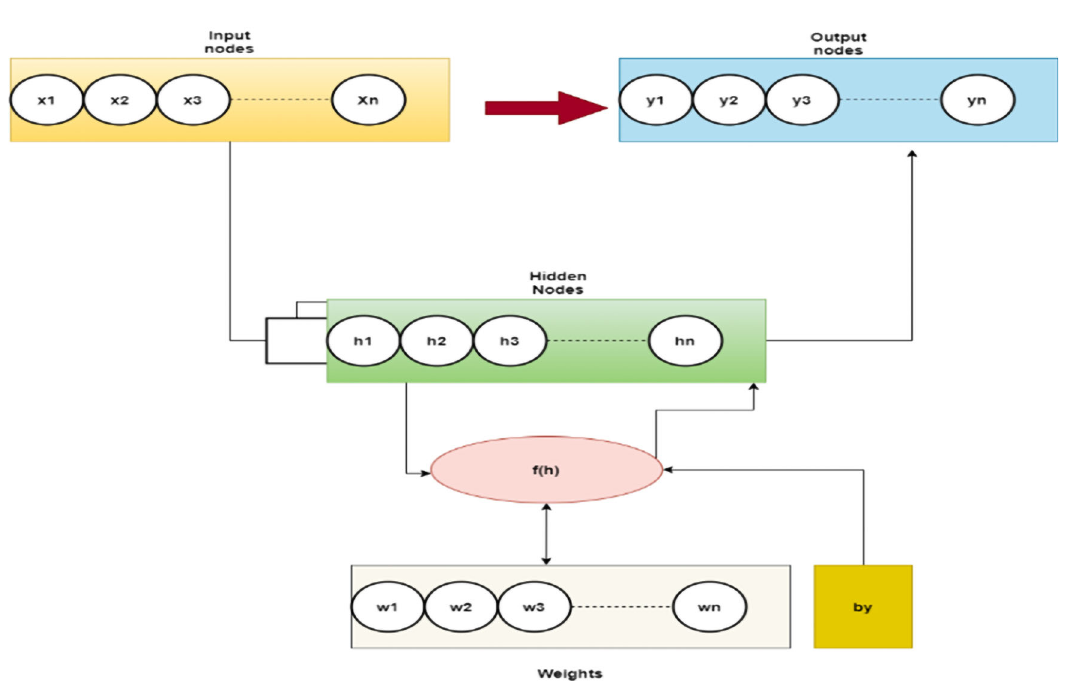
Fig. 3 The architecture process – systematic creation of a